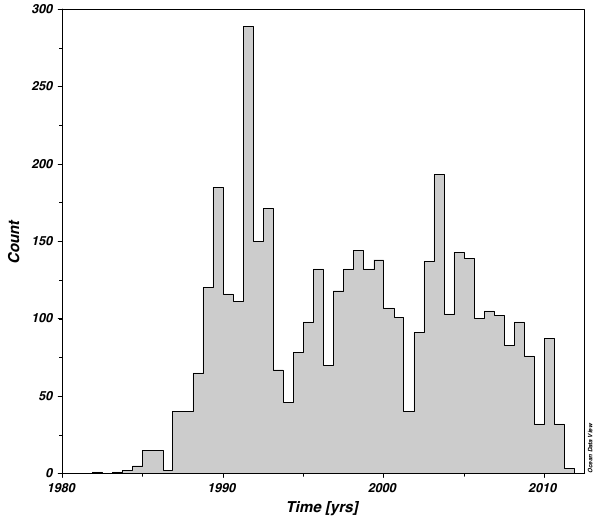
Figure 2. Data–time distribution histogram.